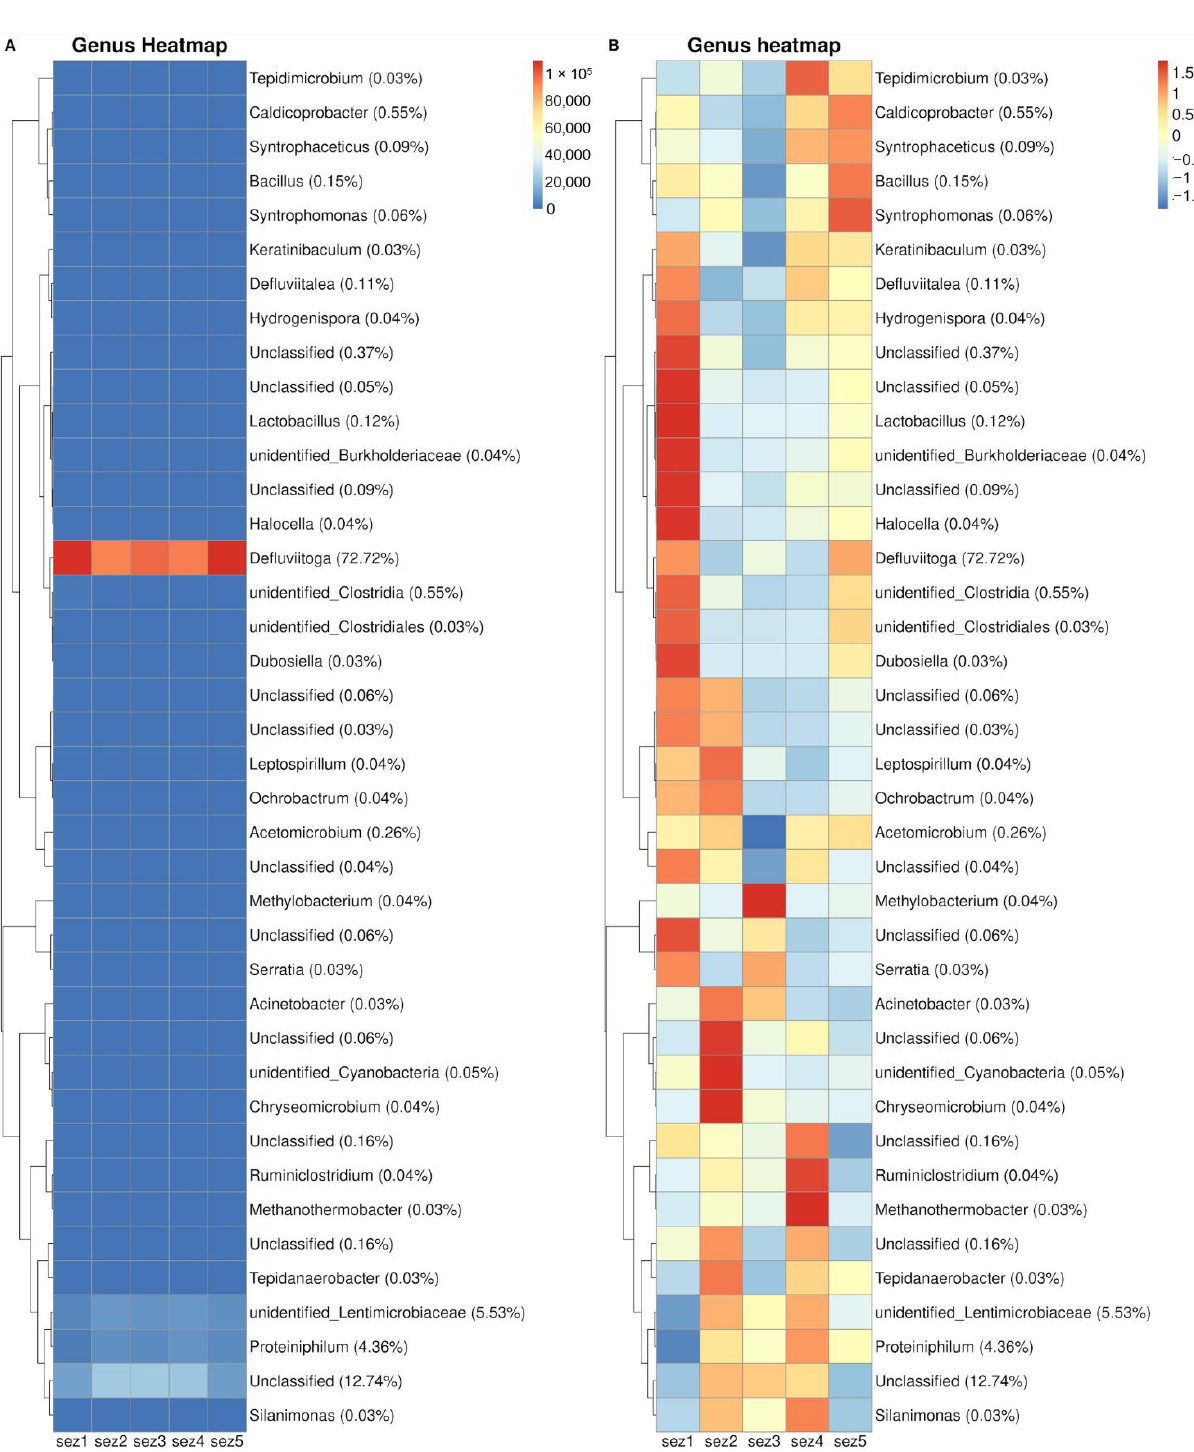
Figure 8. Taxonomic heatmaps at the genus level. Taxonomic heatmaps showing the most abundant ASVs per section: ( A ) absolute counts and ( B ) autoscaled counts, aggregated at the genus level. Percentages reported near the ASV names represent the relative abundance of the sum of ASV counts per sample against the total sum: a cut-off value of 0.005% was chosen. Hierarchical clustering was performed on rows by Pearson correlation, based on Euclidean distance. In order to evidence variation, the color scheme of panel B, representing row-wise Z-scores of ASV counts per sample, was chosen. For this color scheme, a Z value of 0 matches the reported percentage near the ASV names.